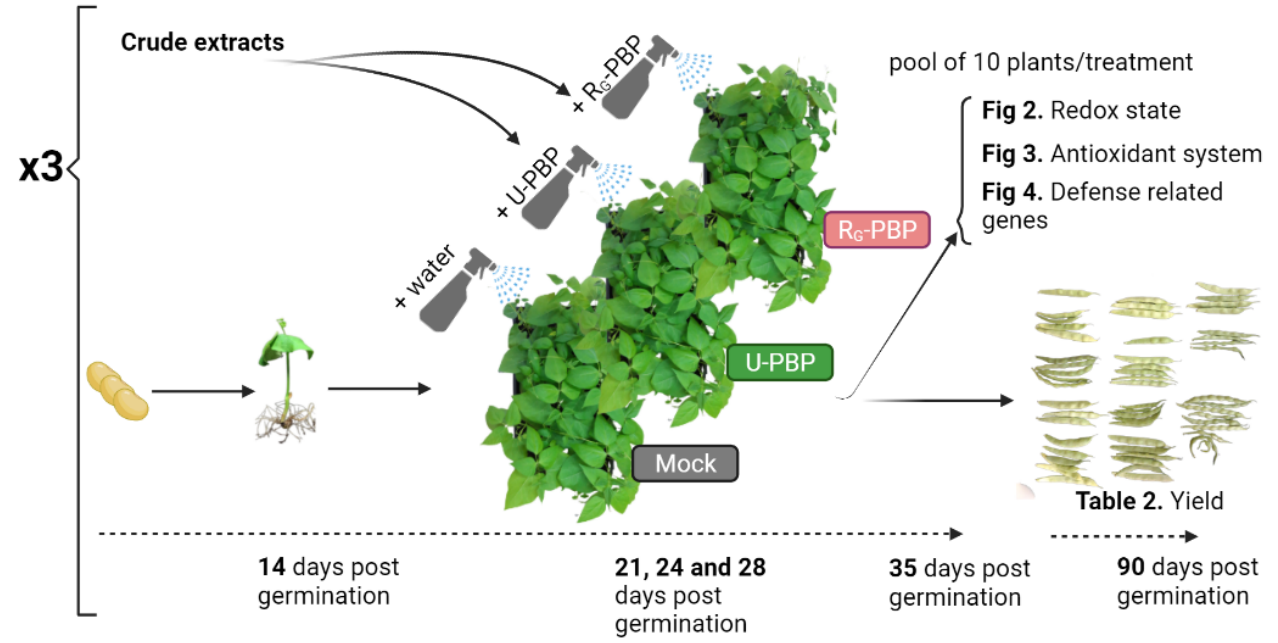
Figure 1. Experimental design. Seeds of common bean P. vulgaris L. cultivar Riñón were grown ex vitro . Leaves from common bean plants were sprayed with water (Mock), Urtica dioica (U), or grape- vine pomace (R G ) plant-based preparations (PBPs) at 21-, 24-, and 28-days post germination.